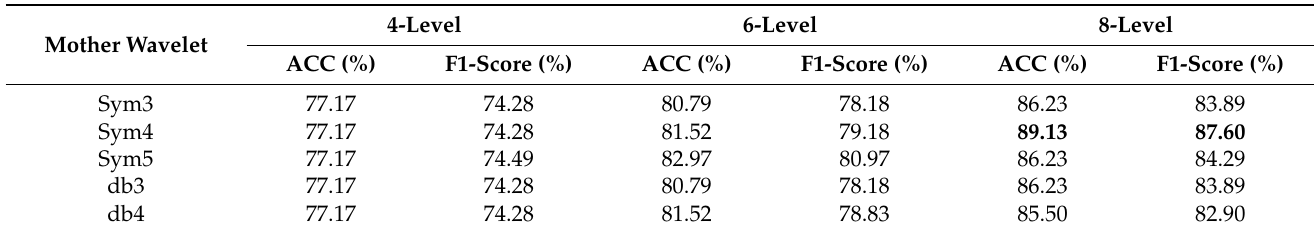
Table 5. The top five mother wavelets that exhibit optimal performance among the three wavelet